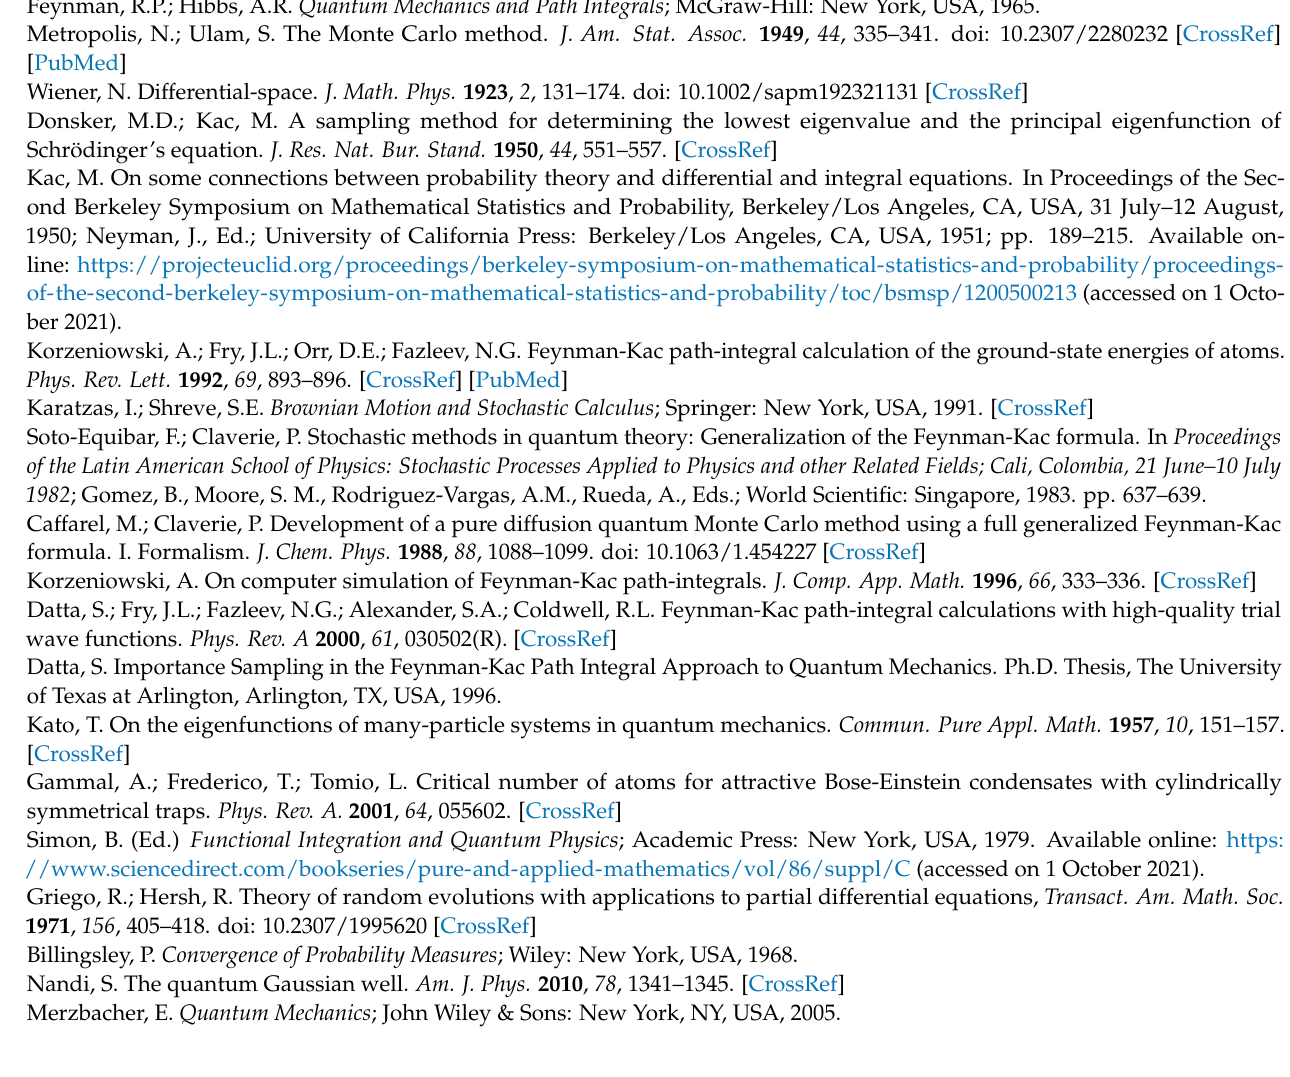
related to width of the Gaussian potential), which leads to N = ( 2/ For finite V 0 and α , N is also finite. Therefore, the number of bound states is finite for the Gaussian